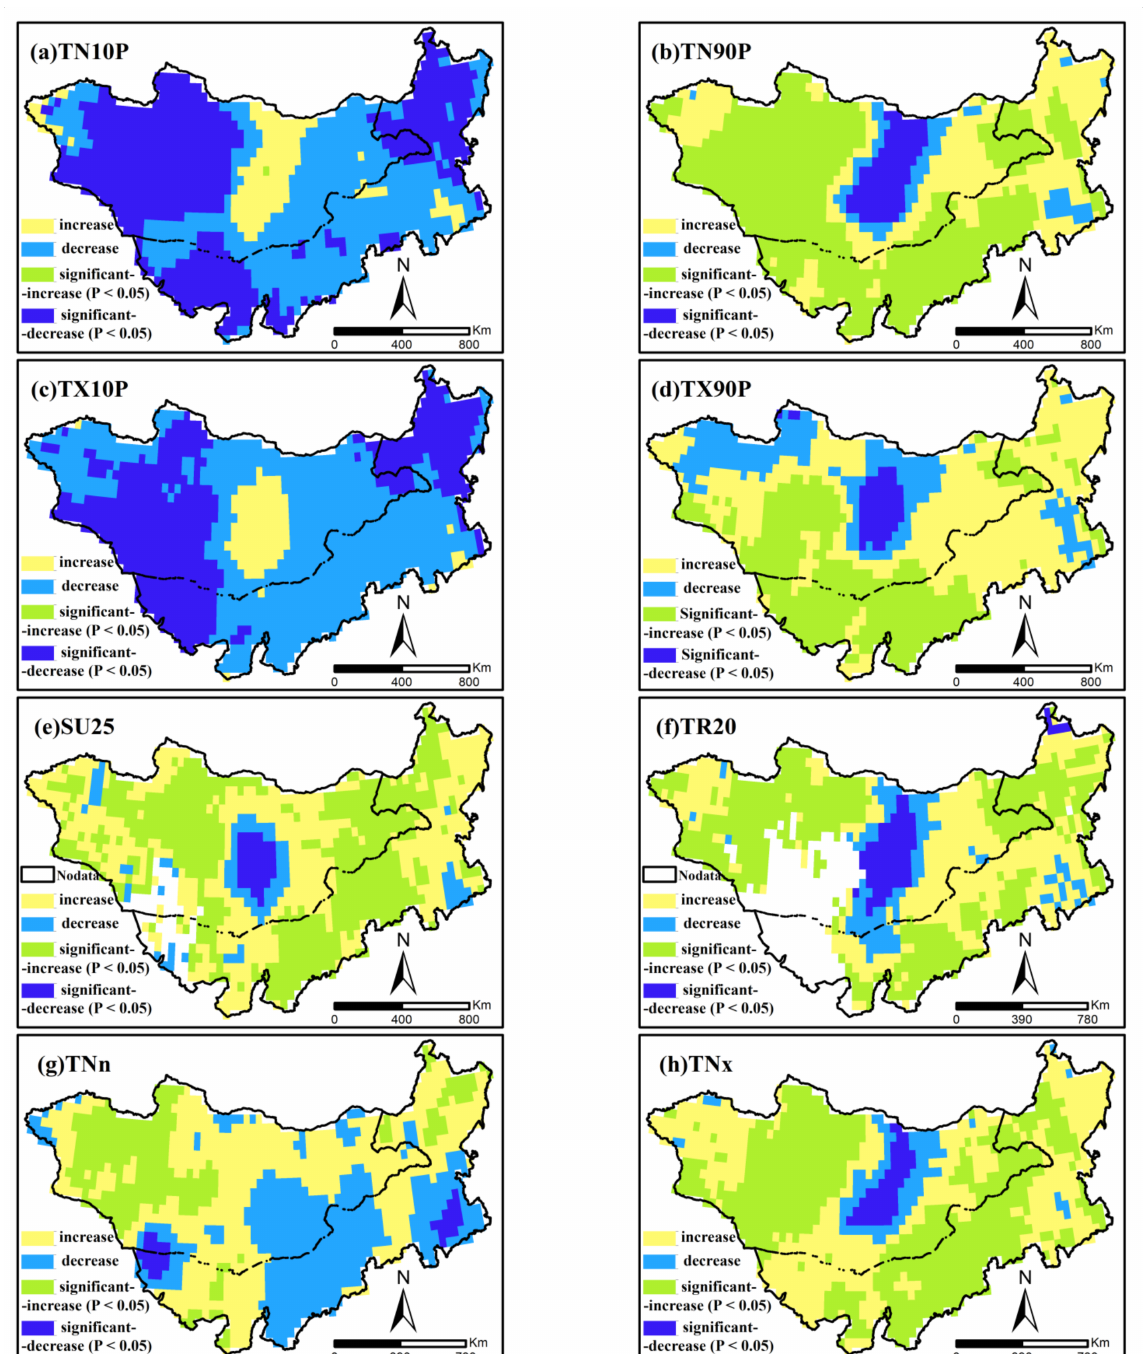
Figure 4. Spatial variation in the extreme temperature index on the Mongolian Plateau over the last three decades.(Spatial trends of each extreme temperature index, ( a ) TN10P: Cold nights, ( b ) TN90P: Warm nights, ( c ) TX10P: Cold days, ( d ) TX90P: Warm days, ( e ) SU25: Hot summer days, ( f ) TR20: Nights stay hot, ( g ) TNn: An extremely low daily minimum temperature, ( h ) TNx: An extremely high daily minimum